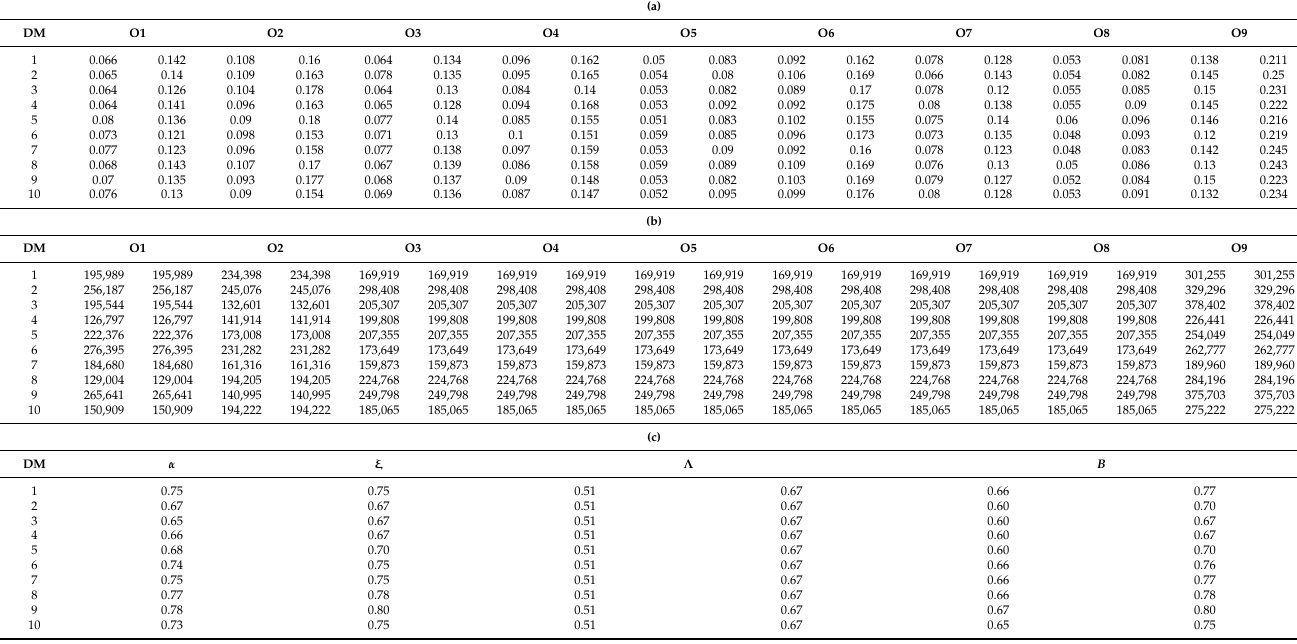
Table A2. Parameters values of the model: (a) weight, (b) veto thresholds and (c) credibility and majority